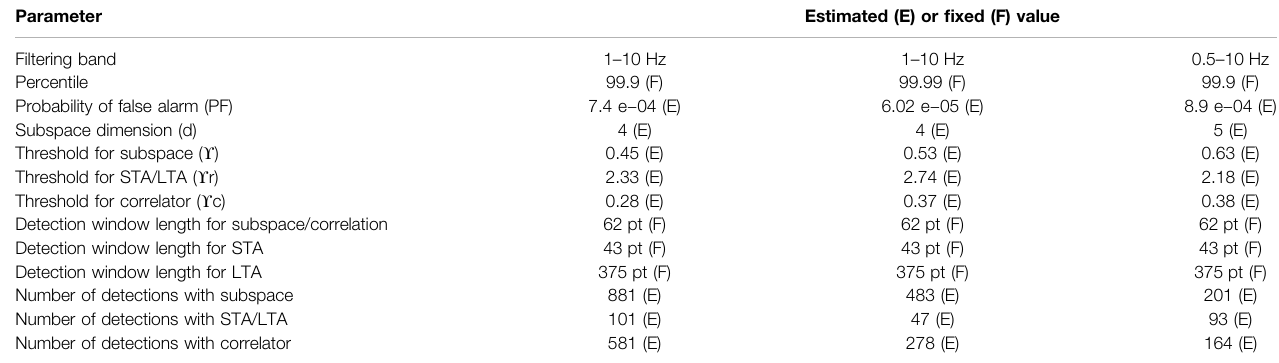
TABLE 1 | Setting parameters estimated or fi xed in the detection. Parameter Estimated (E) or fi xed (F) value Filtering band